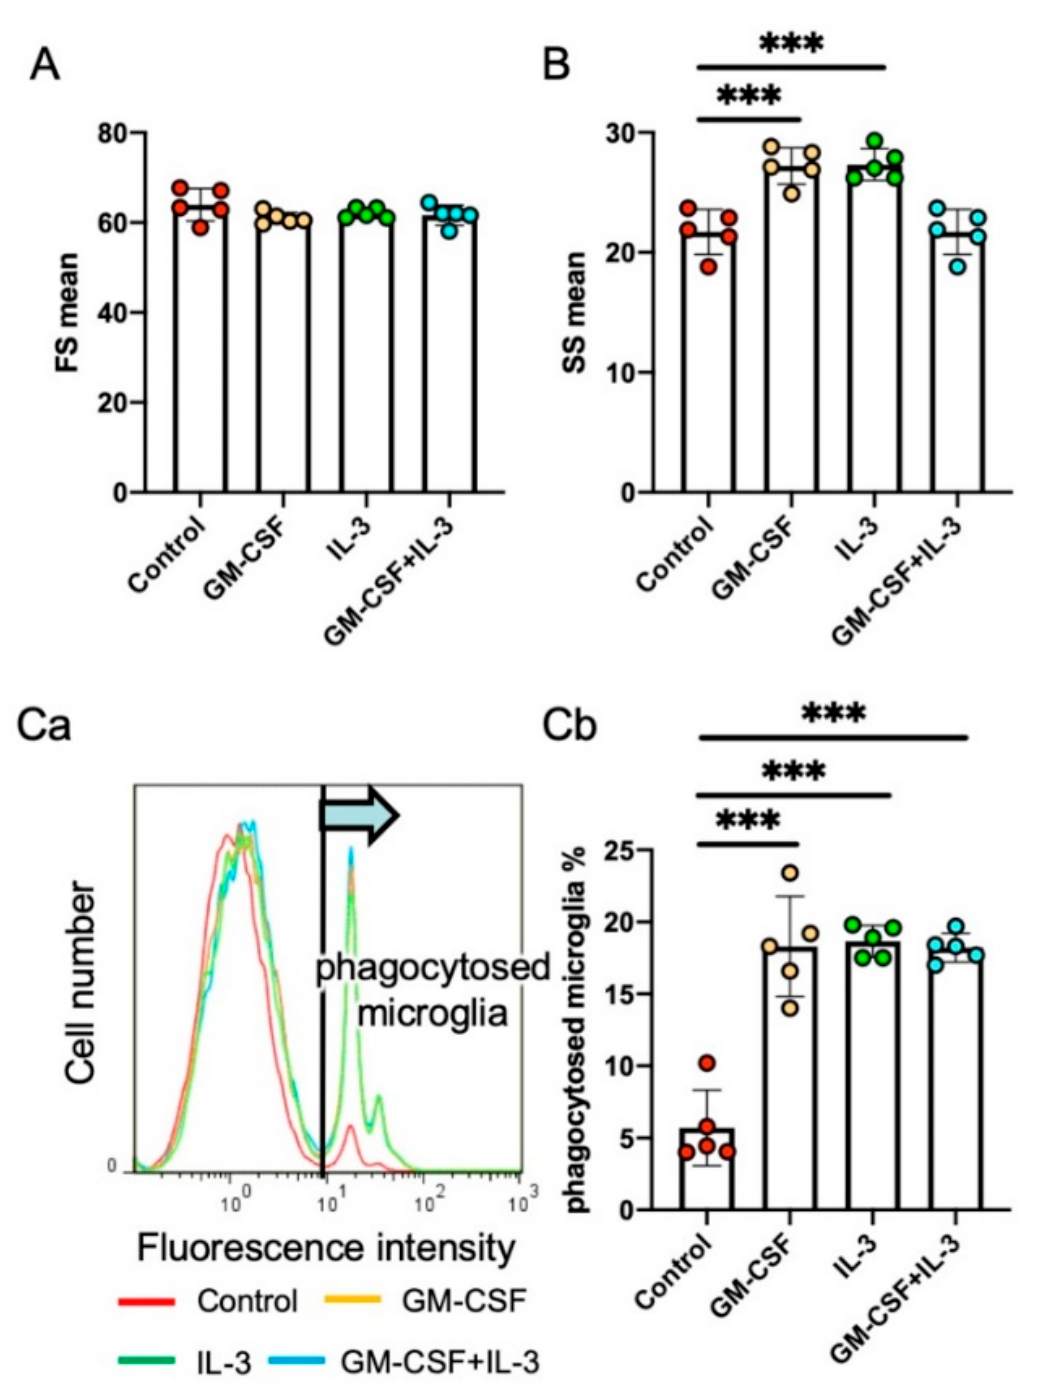
Figure 2. Effects of the cytokines granulocyte/macrophage colony-stimulating factor (GM-CSF) and IL-3 on primary rat microglia. Effect of GM-CSF, IL-3, and GM-CSF + IL-3 on the morphology of rat primary microglia (forward scatter (FS; [ A ]) and side scatter (SS; [ B ])) and their phagocytic internalization of fluorescence-labeled latex beads (C, representative histogram ( Ca ) and the percentage of phagocytosed microglia ( Cb )) as measured by flow cytometry. Data are expressed as mean ± standard deviation. Unpaired two-tailed t-test. *** p < 0.001. Detailed information on the methodology for preparation of rat primary microglia culture and flow cytometry analyses is described elsewhere [96,107]. Figure 3. Neuronal viability and microglial phenotype changes in the SNc of a rat PD model. ( A ) With age, a toxic milieu forms around the DAergic neurons and adds to the intrinsic toxic mecha ‐